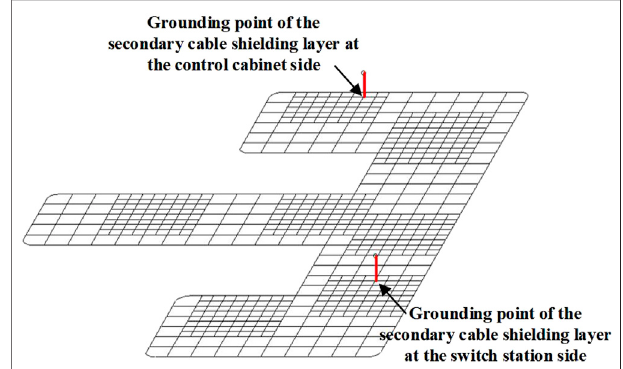
FIGURE 3 | Grounding grid